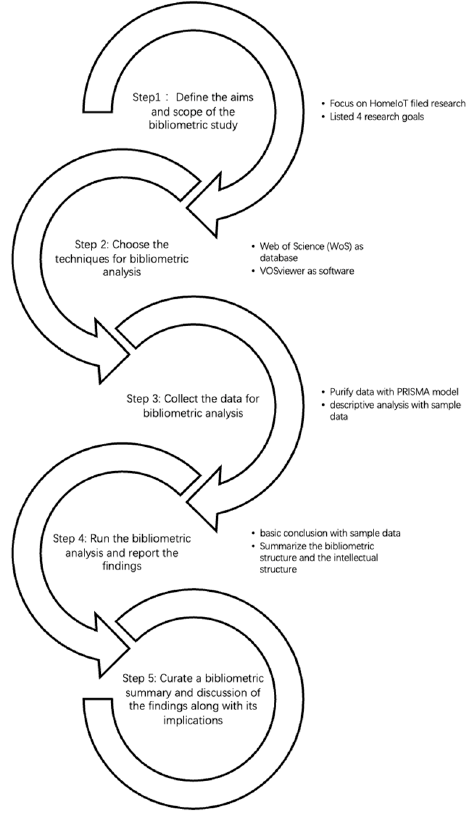
Figure 1. The bibliometric analysis procedure.